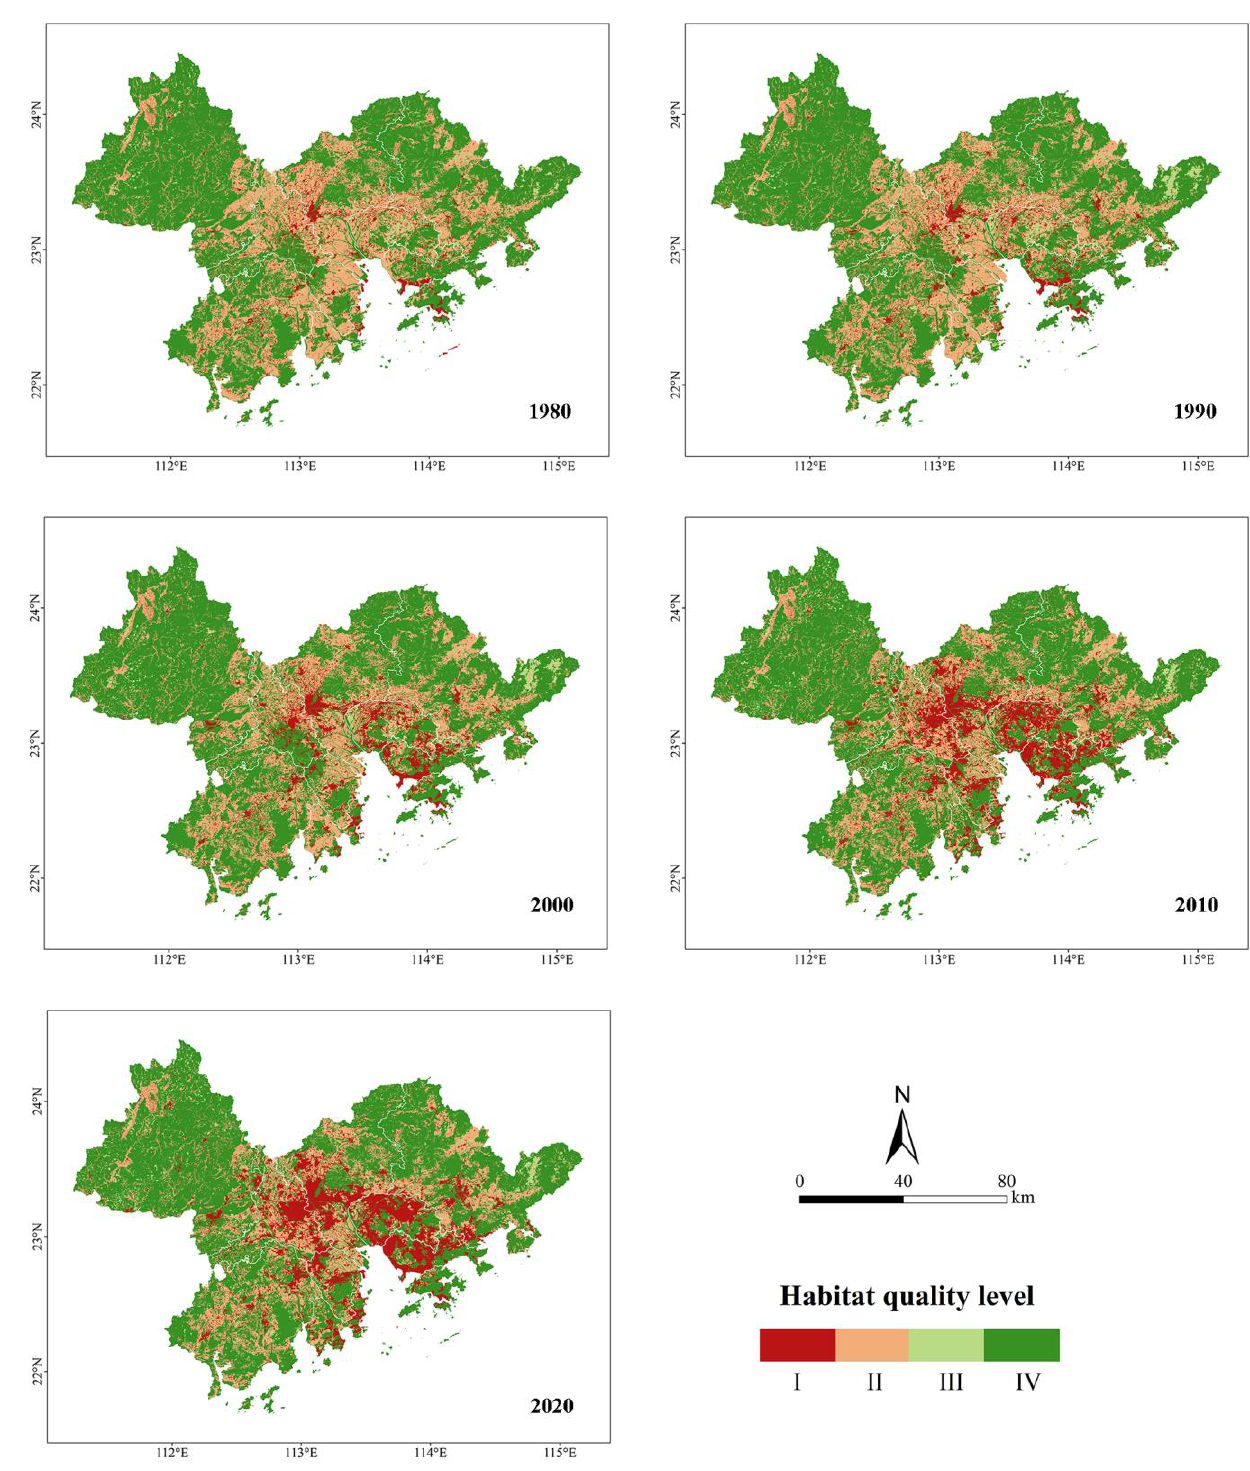
Figure 10. Spatial and temporal variation in habitat quality level. Spatially, it showed that the habitat quality was lower in the middle of GBA and higher in its surroundings. The level of habitat quality differed significantly within the different cities. As the leading cities, the average values of the habitat quality index in Guangdong and Shenzhen were only 0.68 and 0.60, respectively. The habitat quality of cities along the Pearl River, including Dongguan, Foshan, Zhongshan, and Zhuhai, were